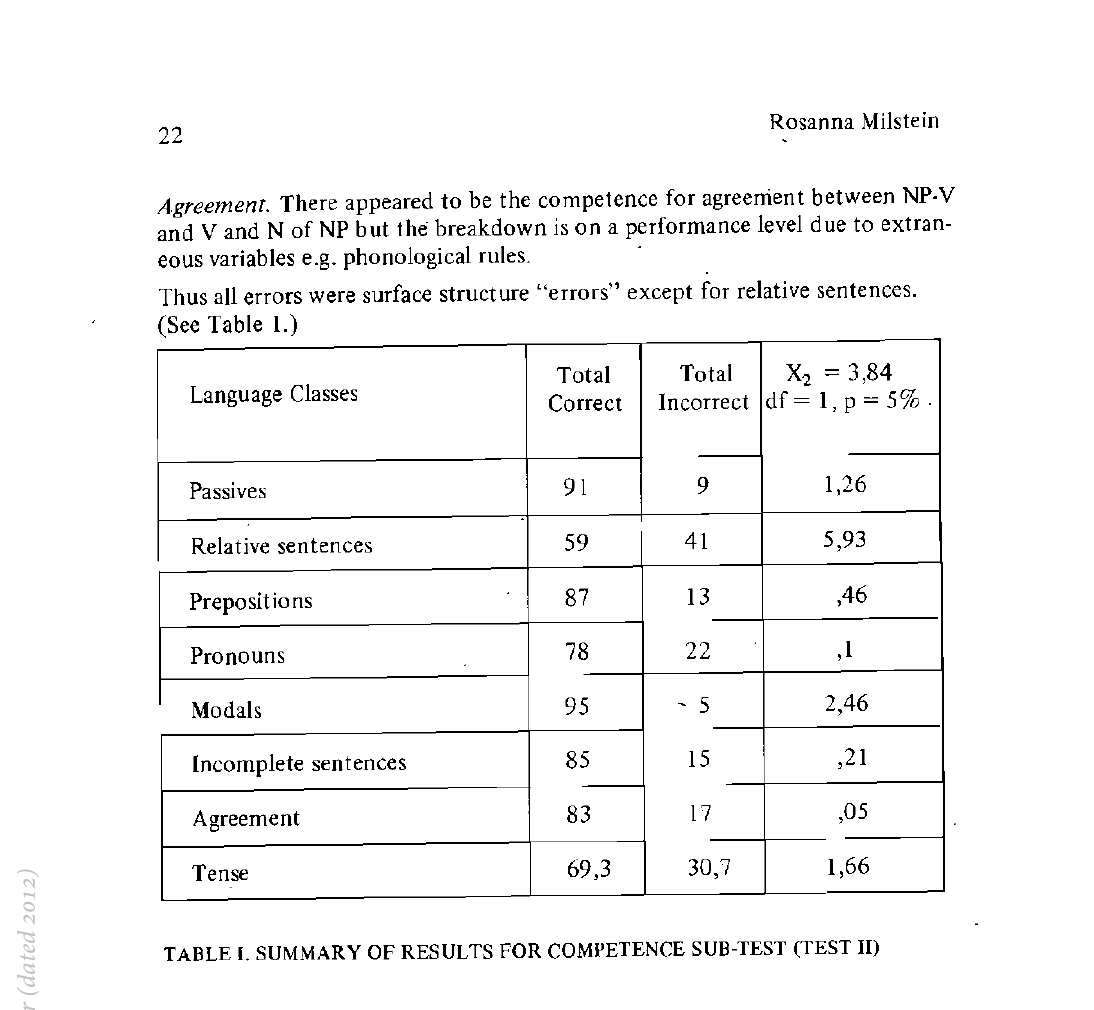
TABLE I. SUMMARY OF RESULTS FOR COMPETENCE SUB-TEST (TEST